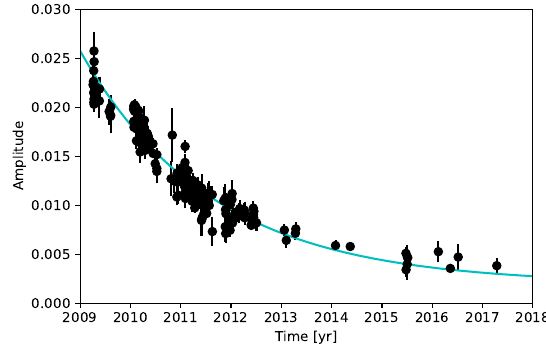
Figure 1. Amplitudes of the 371.7 s pulsation mode taken from least–squares fits to individual light curves from PROMPT. The solid line denotes the best–fitting exponential function to the data, il- lustrating a clear, nonlinear decay over an eight–year period. Only amplitudes taken from “white light” measurements through clear or open filters are